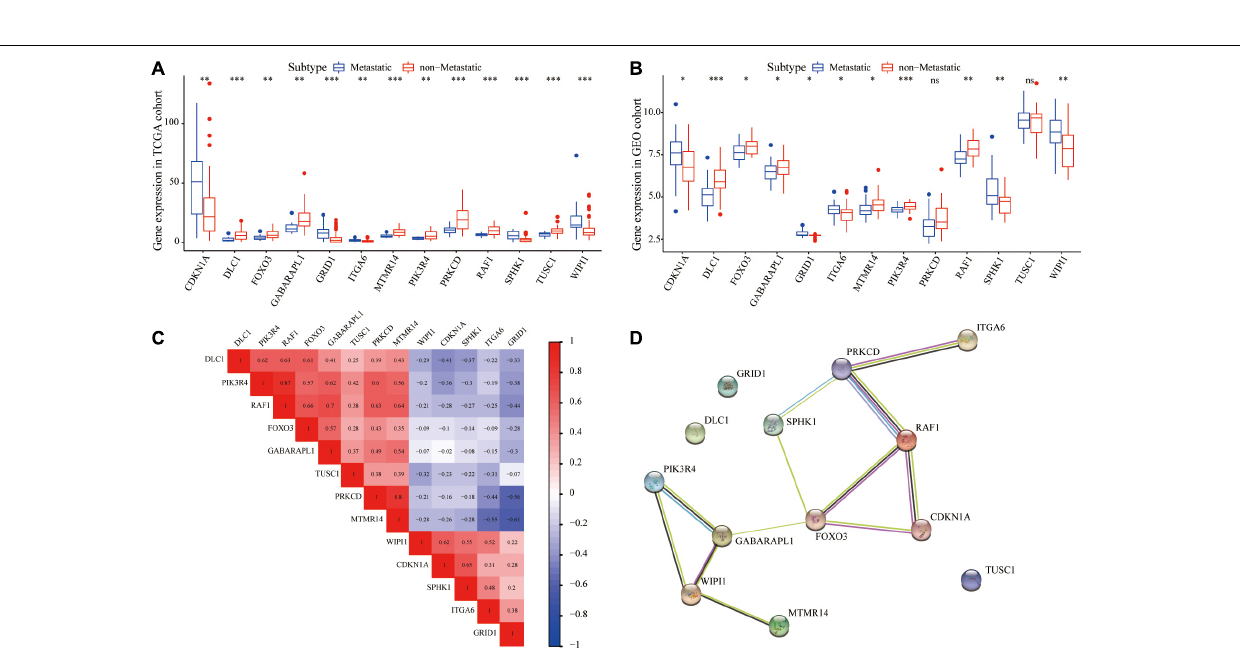
FIGURE 2 | Identification of autophagy differentially expressed genes (DEGs). (A) Heat map of the 1,107 DEGs between metastatic and non-metastatic UM. (B) Venn diagram of 13 autophagy DEGs. (C) GO functional enrichment analysis of autophagy DEGs. (D) KEGG pathway analysis of autophagy DEGs.